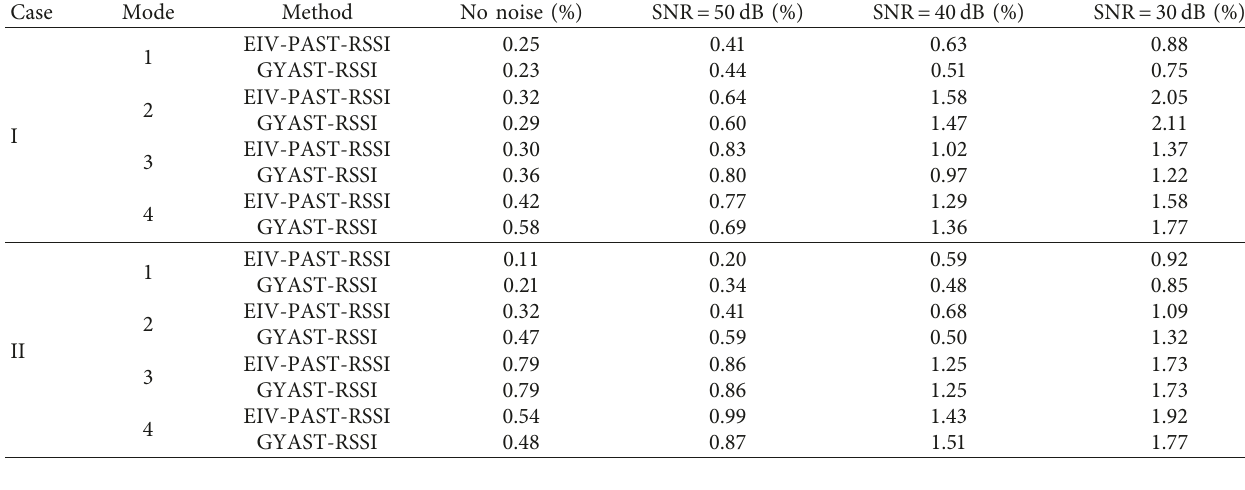
Table 1: A comparison of the ARE of time-varying modal identification results for frequencies using the EIV-PAST-RSSI and GYAST-RSSI methods.